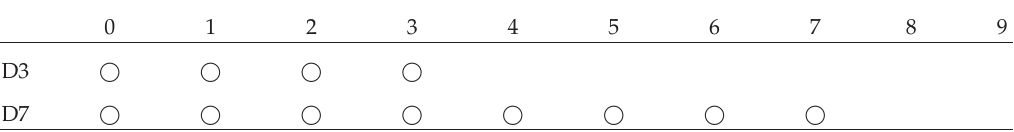
Table 3: The D3/D7-brane intersection in 9 (cid:8) 1-dimensional flat space.